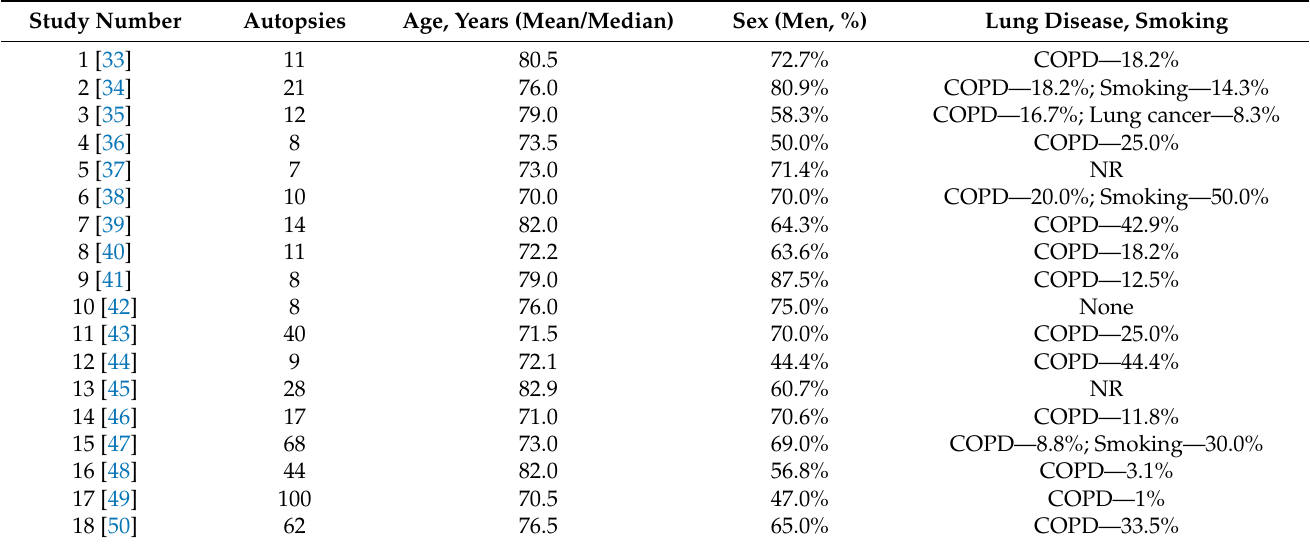
Table 2. Summary of findings in the included